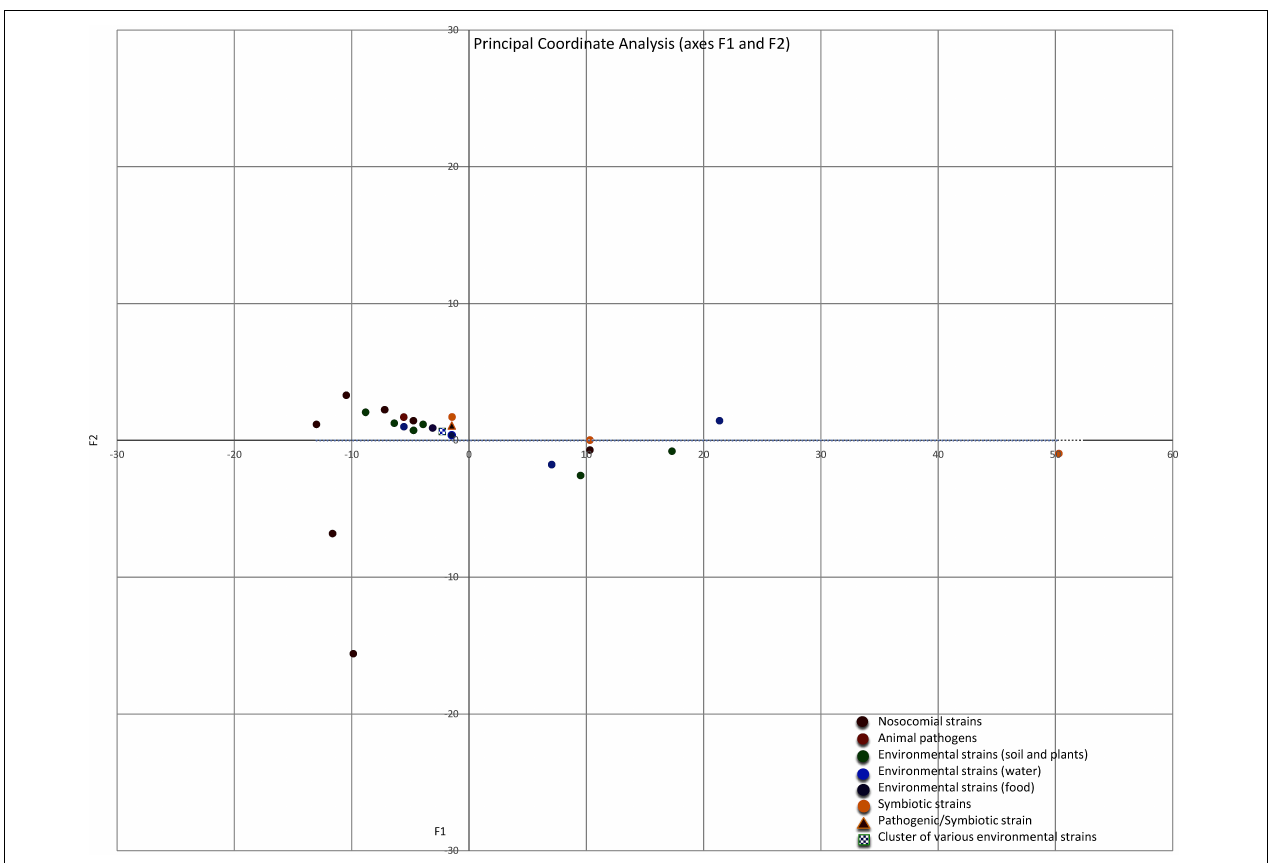
FIGURE 8 | Principal Coordinate Analysis (PCoA) plot depicting Euclidean distances between resistomes of nosocomial strains (red), animal pathogens (orange), environmental associated with soil and plants (green), environmental isolated from water (blue), environmental isolated from food (purple), and environmental symbiotic bacteria (yellow) calculated using ARGs counts. The blue and green square represents a group of many strains isolated from water and soil/plants, the triangle represents de pathogen/symbiotic strain S.